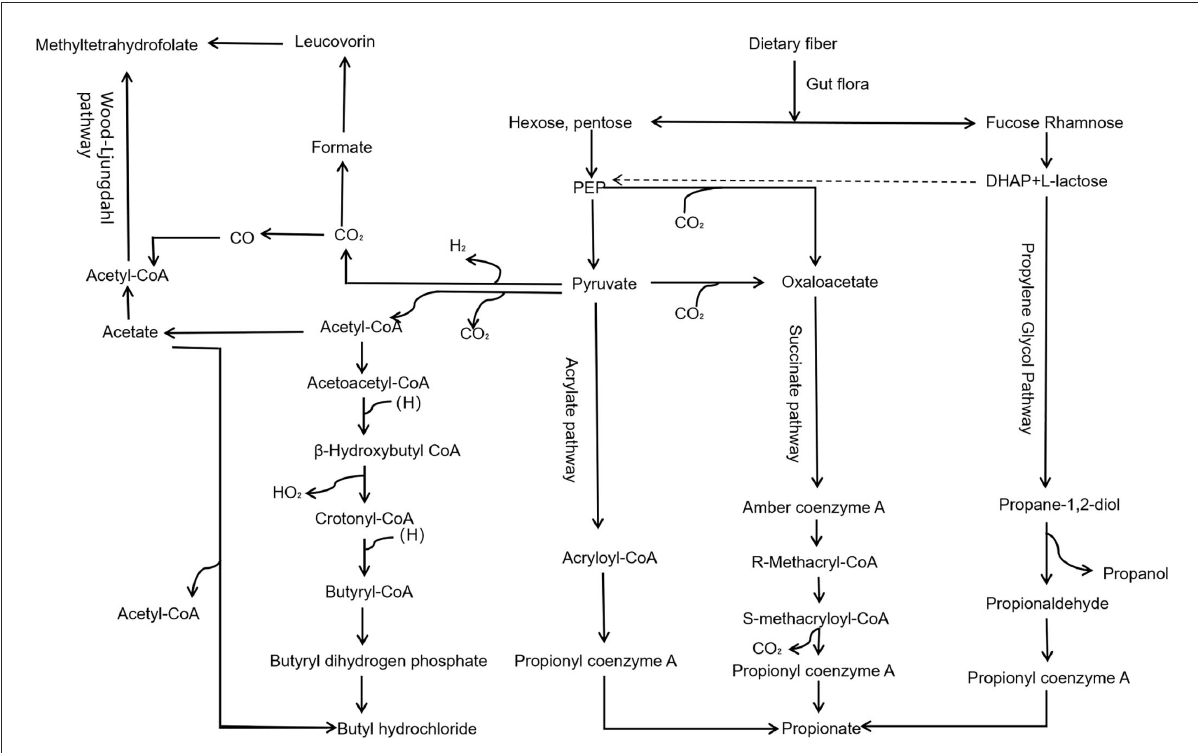
FIGURE2 Pathway of dietary fiber generates SCFAs via gut microbiota. Dietary fiber in the gut, through propylene glycol, succinate, acrylate, and Wood–Ljungdahl pathway, generates important metabolites, such as SCFAs, including acetate, propionate, and